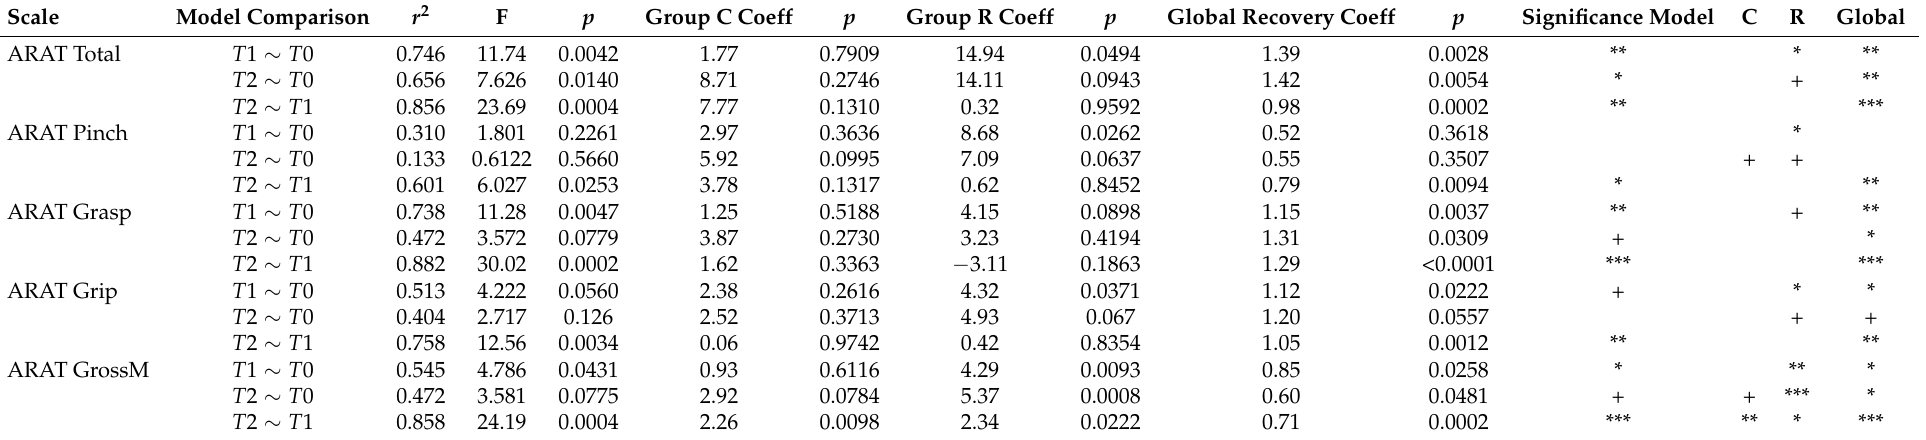
Table 3. ARAT score longitudinal analysis through mixed models. Model comparison reports the coefficient of determination, F score, and p -value. For each model coefficients are reported alongside with p -values. Significance: + 10%; * 5%, ** 1%, *** 0.1%.